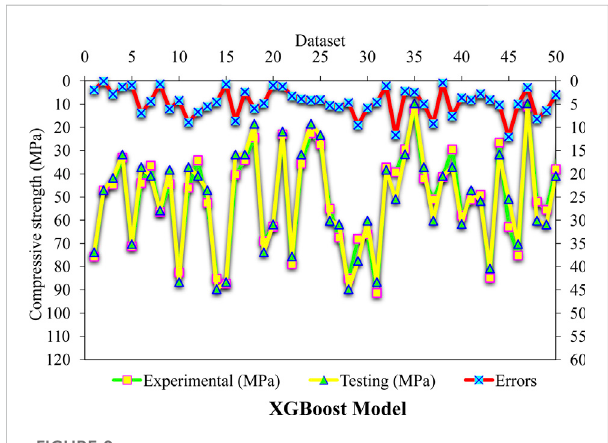
FIGURE 9 XGBoost estimated and experimental values distribution with errors.